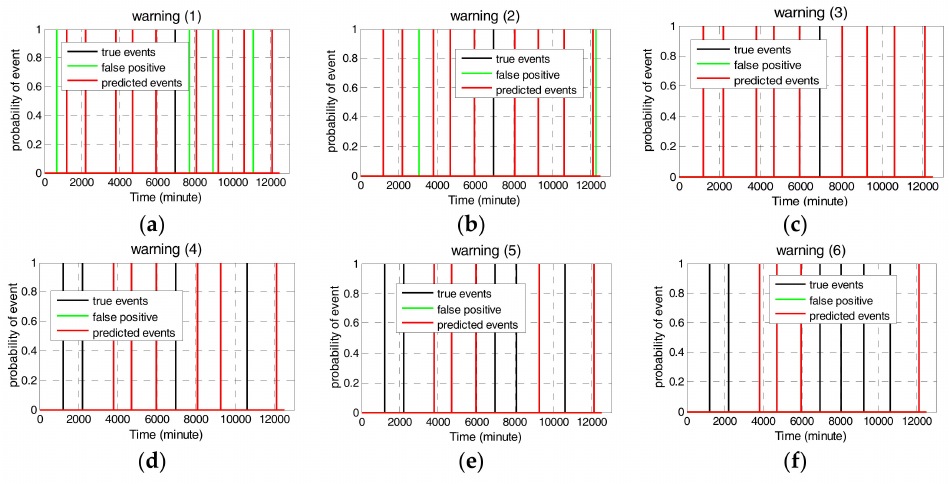
Figure 6. Event probability of multiple water quality parameters.